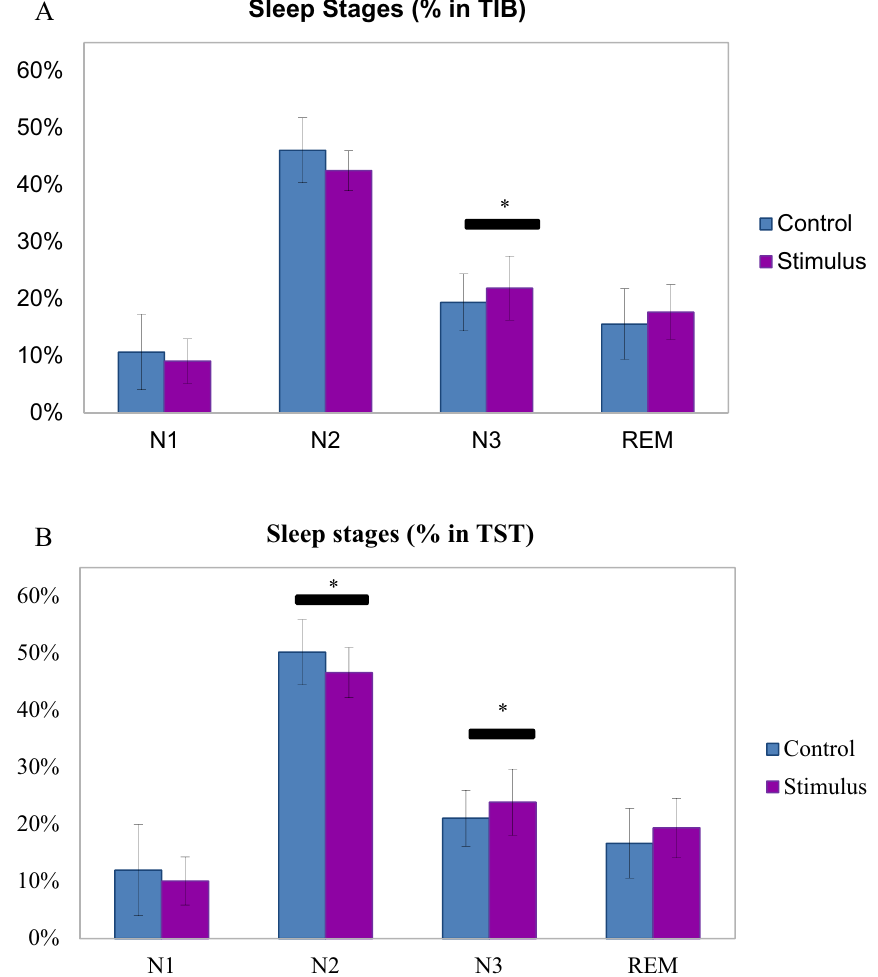
Figure 5. Lavender aroma promotes deeper sleep stages. ( A ) Sleep stages percentage in TIB. Percentage of N3 stage was increased in stimuli night. ( B ) Sleep stages percentage in TST. Percentage of N3 stage was increased while that of N2 was decreased in stimuli